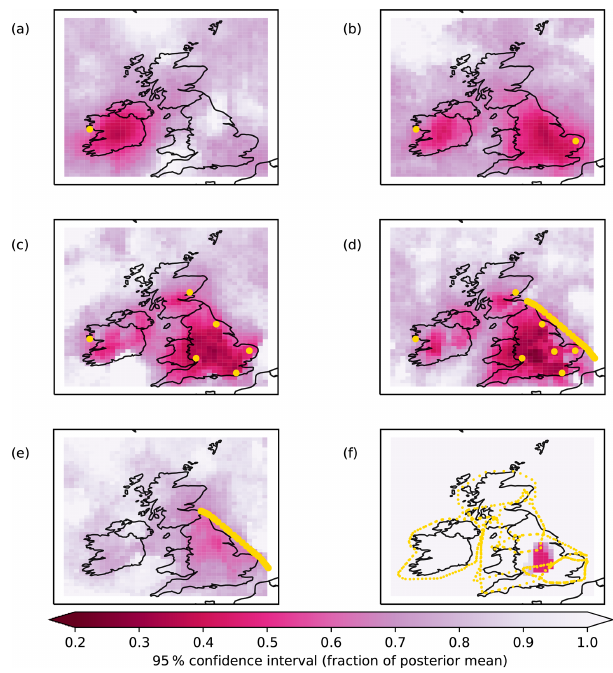
Figure 7. Posterior 95% confidence interval for 2015 as a fraction of the posterior estimate for each grid box. Darker colours indi- cate regions of lower uncertainty. Maps are shown for the follow- ing different measurement networks: (a) MHD, (b) MHD–TAC, (c) DECC network, (d) GAUGE network (DECC + GLA + ferry), (e) ferry and (f) FAAM aircraft (2014). Gold dots indicate locations of measurements used. The plot extent is not indicative of the inversion domain.